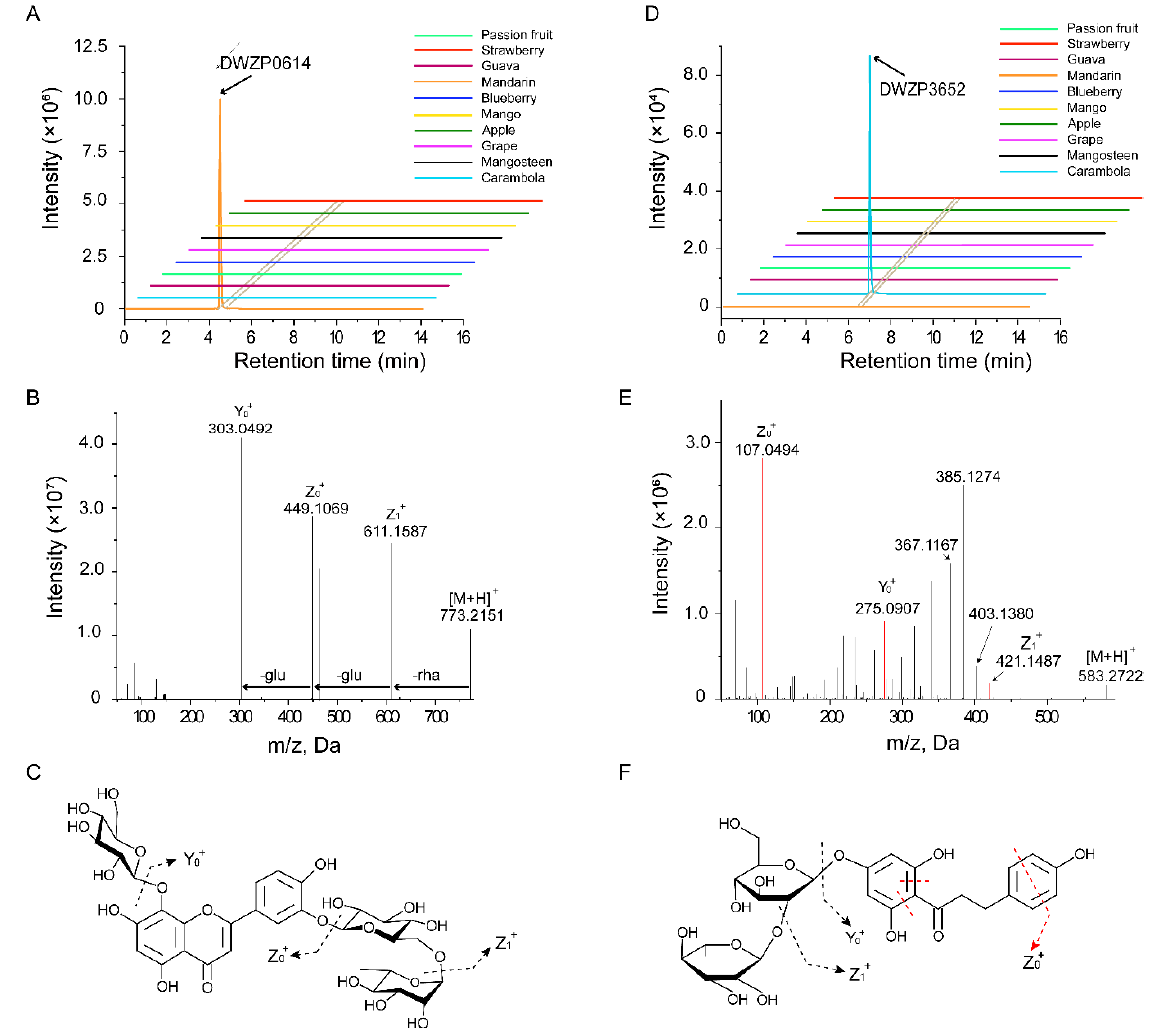
Figure 2. Detection and identification of specific metabolite signs by Q Exactive Focus Orbitrap LC-MS/MS. ( A ) Extracted ion chromatogram (EIC) of DWZP0614 at 4.50 min. DWZP0614 is unique in citrus. ( B ) MS/MS spectra of DWZP0614 at m/z 773.2151. The metabolite was identified as 8-hydroxyluteolin 8-glucoside-3’-rutinoside. ( C ) The molecular structure of the 8-hydroxyluteolin 8-glucoside-3’-rutinoside and its general fragmentation rules. ( D ) EIC of DWZP3652 at 6.24 min. DWZP3652 is unique in carambola. ( E ) MS/MS spectra of DWZP3652 at m/z 583.2722. The metabolite was identified as naringin dihydrochalcone. ( F ) The molecular structure of the naringin dihydrochalcone and its general fragmentation rules.